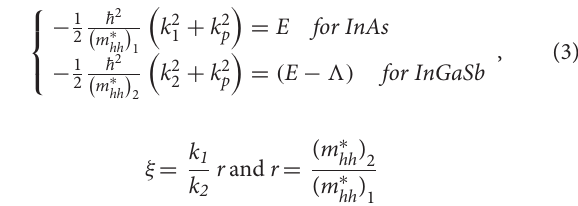
FIGURE 1 | Energy bands alignment in InAs/In 1 axis z. (E c ) i , (E v ) i , and ǫ i where i edges and band gap of bulks, respectively. 1 E v